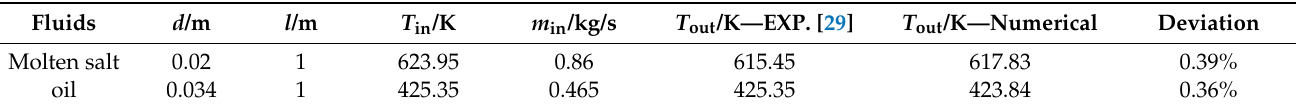
Table 2. Comparison between simulation results and experimental